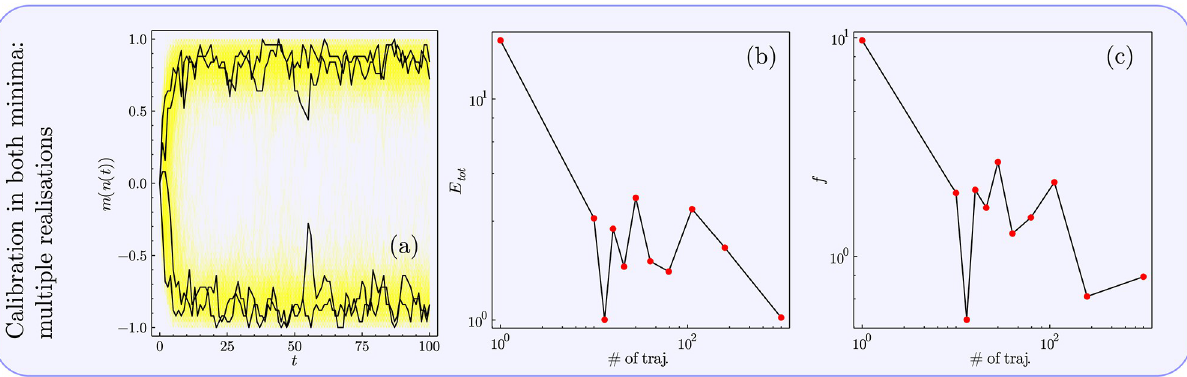
Fig 5. Figure showing the performance of the calibration procedure when one has access to multiple realisations of a binary decision process. (a) We simulated 10 3 trajectories of binary decision data from the SSA for the parameter set used in Fig 3. We emphasise five possible trajectories in the foreground, with the yellow background giving an idea of all the trajectories we used. (b) and (c) show that the model calibration can be significantly improved if one has access to multiple realisations of the same binary decision process. For > 10 2 realisations we find that the errors are typically � 1, which corresponds to a very accurate